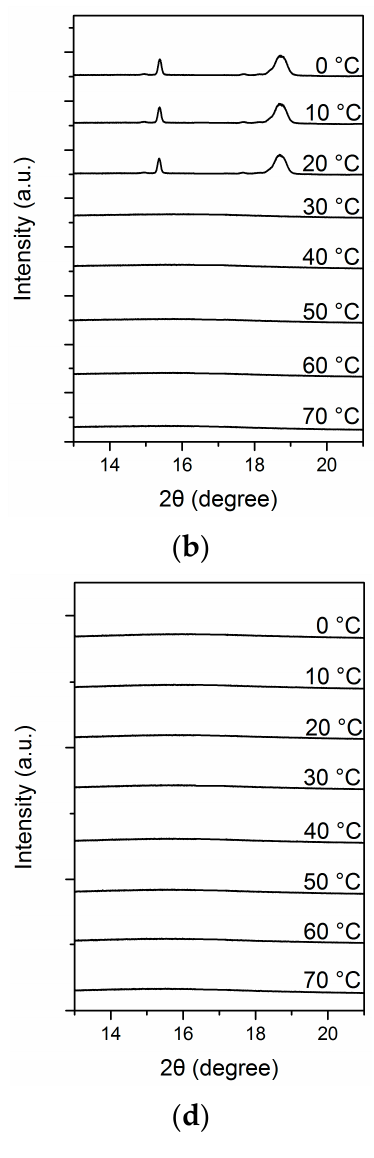
Figure 8. Time-resolved wide-angle X-ray scattering (WAXS) patterns of PEG and its complexes with Azo during nonisothermal crystallization at a cooling rate of 5 ◦ C / min. ( a ) PEG, ( b ) 10:90 Azo / PEG, ( c ) 25:75 Azo / PEG, and ( d ) 50:50 Azo / PEG. The complex compositions are designated in wt %.